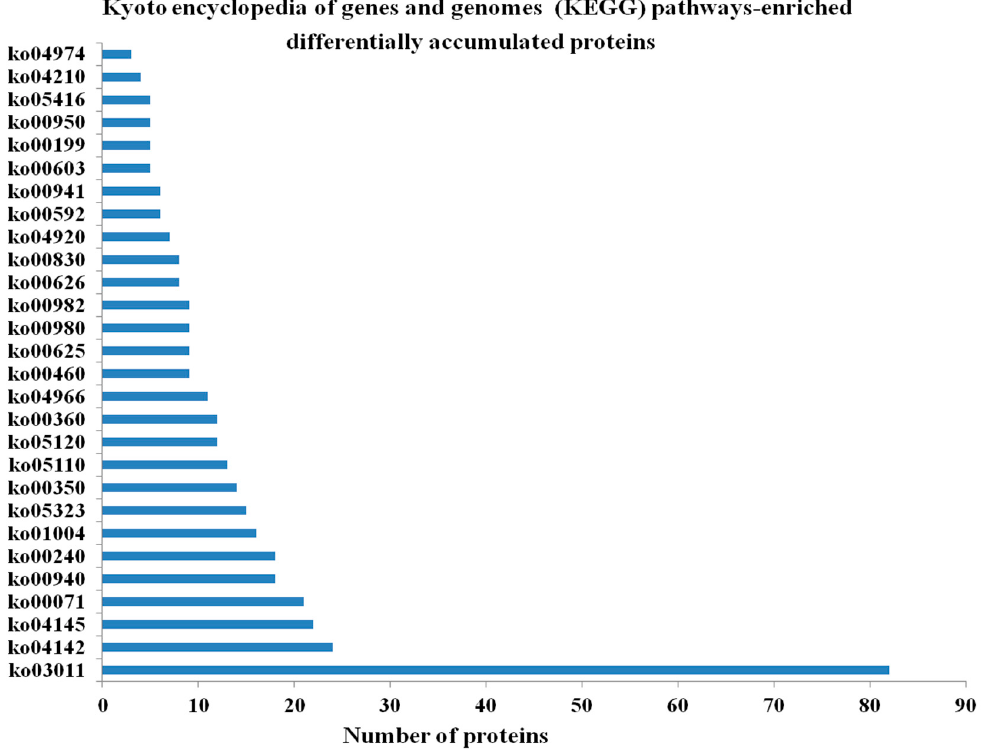
Figure 2. Kyoto encyclopedia of genes and genomes (KEGG) pathways-enriched differentially accumulated proteins during pitaya fruit ripening. ko03011 Ribosome, ko04142 Lysosome, ko04145